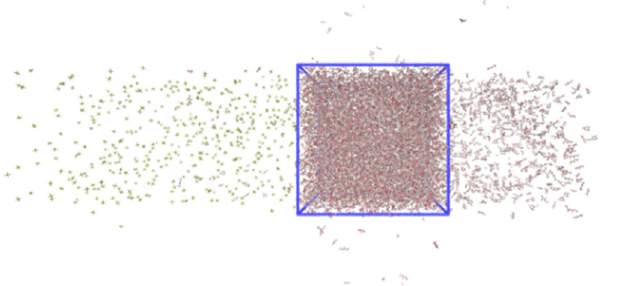
Figure 1. An example of a snapshot of molecules in a non-equilibrium MD simulation conducted with a constant electric field.